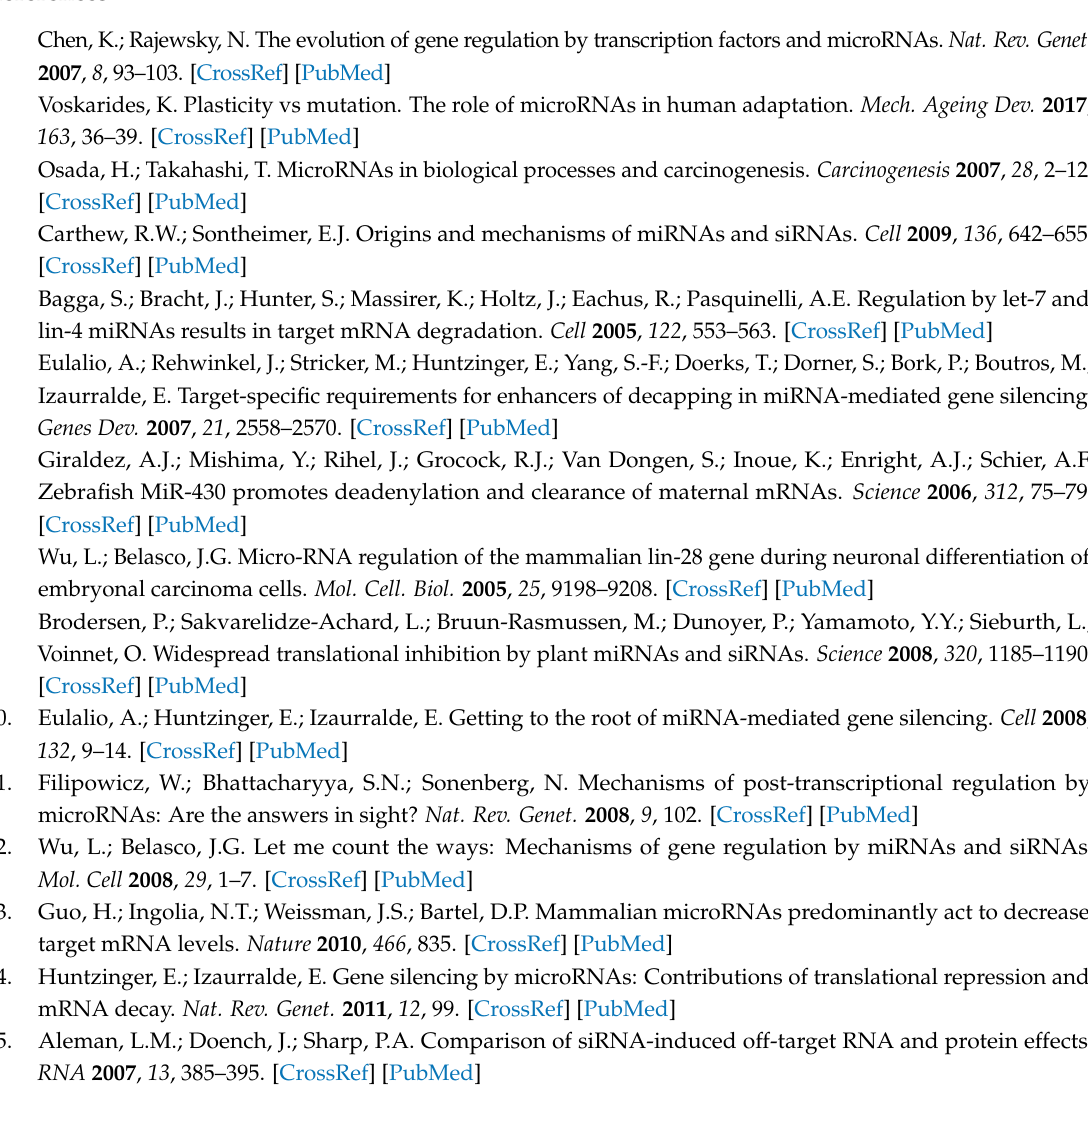
Supplementary Table S1: input list of miRNA–DE gene target, Supplementary Table S2: input complete list of DE genes, Supplementary Table S3: complete output of adjacency matrix, Supplementary Table S4: complete miRNA impact on the gene expression, Supplementary Table S5: complete upregulated DE